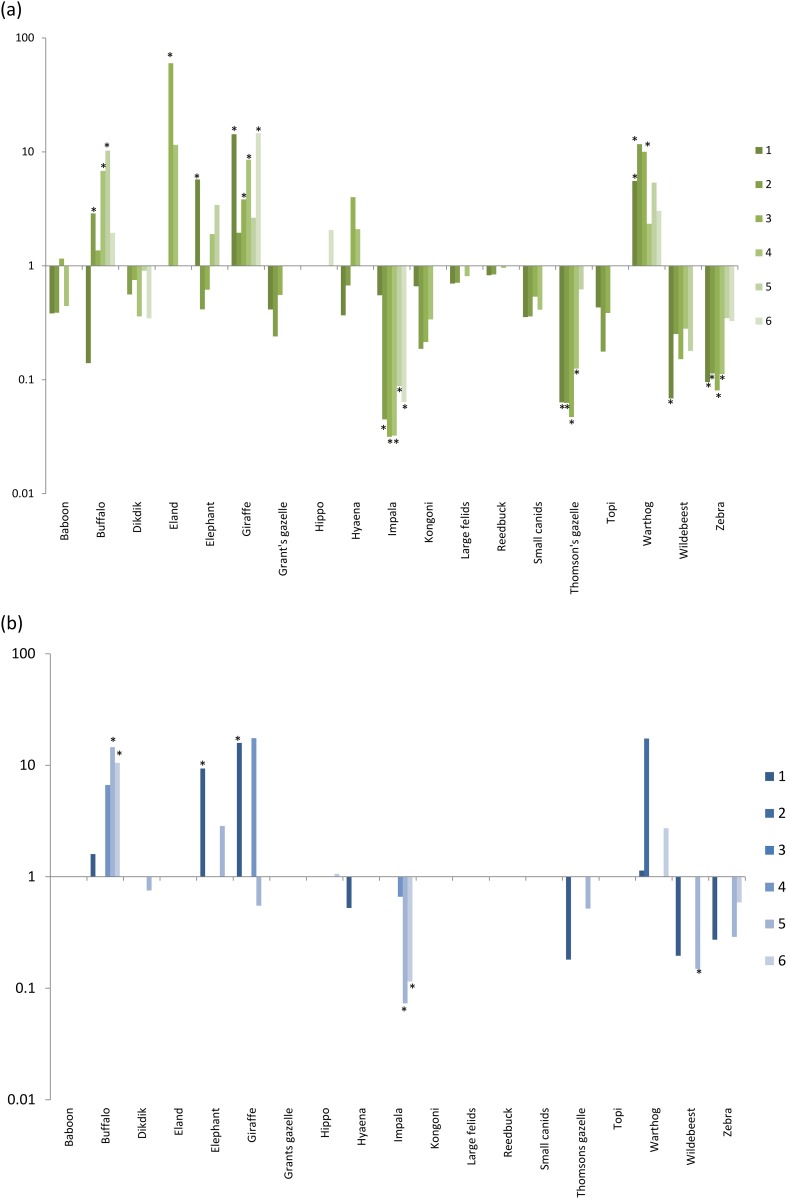
Feeding indices illustrate selection or avoidance of host species by Glossina swynnertoni and G. pallidipes.Feeding indices by species and study site on a log scale. Graded colours show the feeding index at each of 6 study sites. Values above 1 indicate a host is selected, values below 1 indicate a host is avoided, by (a) G. swynnertoni and (b) G. pallidipes. Stars indicate significance at p<0.05.